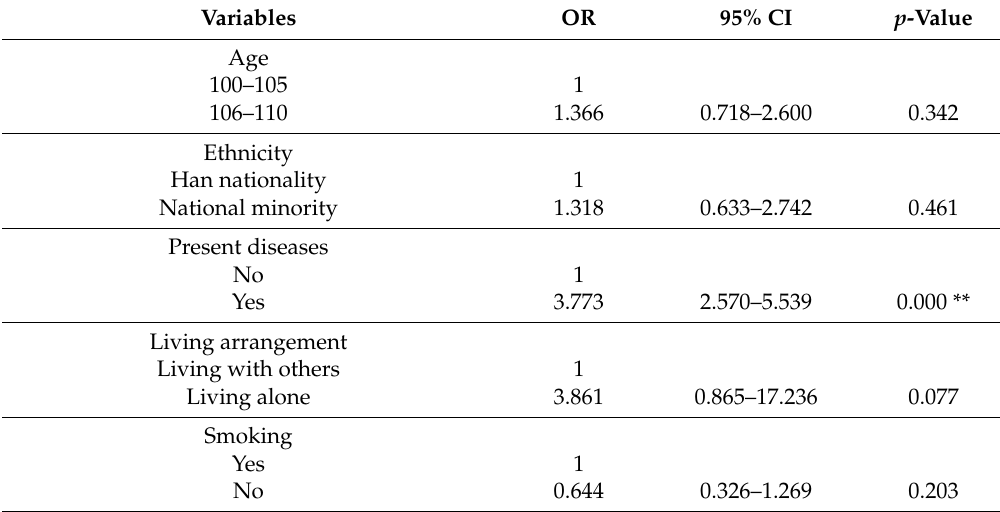
Table 2. Bivariate logistic regression analysis for the association between factors and ADL